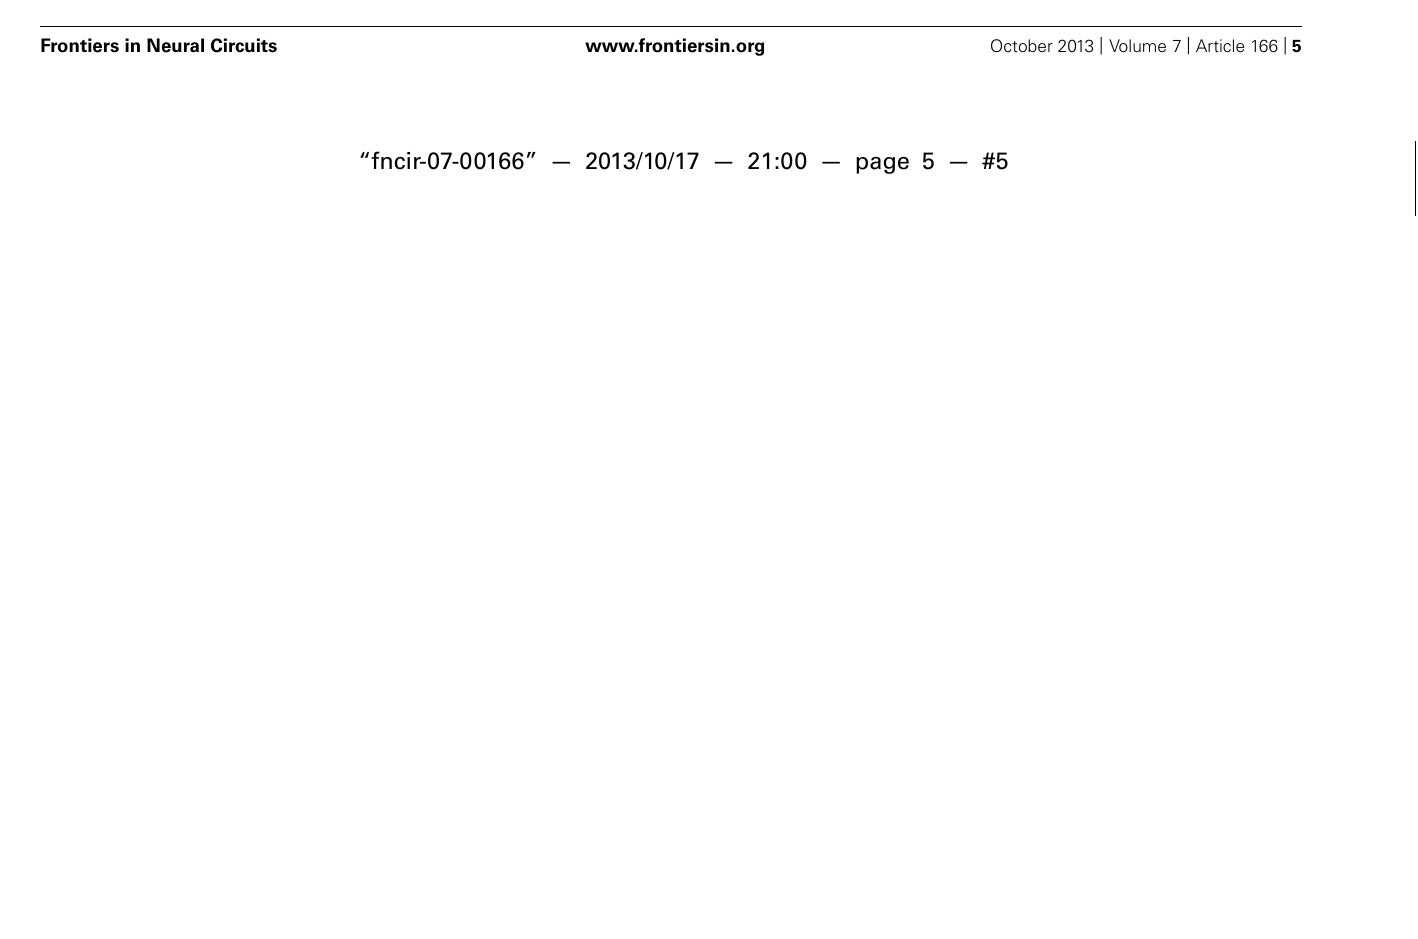
from 700 Hz to 30 kHz) and scaled from sound pressure to stapes velocity . The output of the DRNL model is obtained from summing the linear path and non-linear path components.The envelope of the DRNL model (i.e., what we define as the DRNL output ) is then extracted using the Hilbert transform method and smoothed by a 10 ms sliding window average to obtain the slower fluctuations of the signal (see Materials and Methods for further details).The envelopes for the other signal components were extracted in the same way and displayed in the figure for visualization.The post-stimulus time histogram (PSTH), which was also smoothed with a 10 ms sliding window average, shows the neural activity recorded in a 2.9 kHz frequency lamina in response toTSV shown in Figure 1 .The best frequency of 2.9 kHz was used for the DRNL model to obtain the different envelope signals shown in the figure, except for stapes velocity, which is independent of best